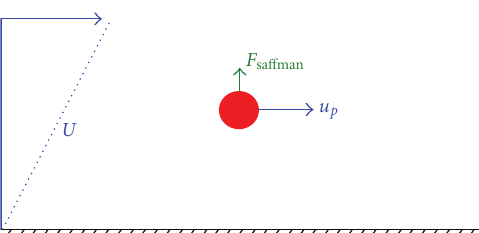
Figure 8: Schematic illustrating direction of Sa ff man force in shear flow.